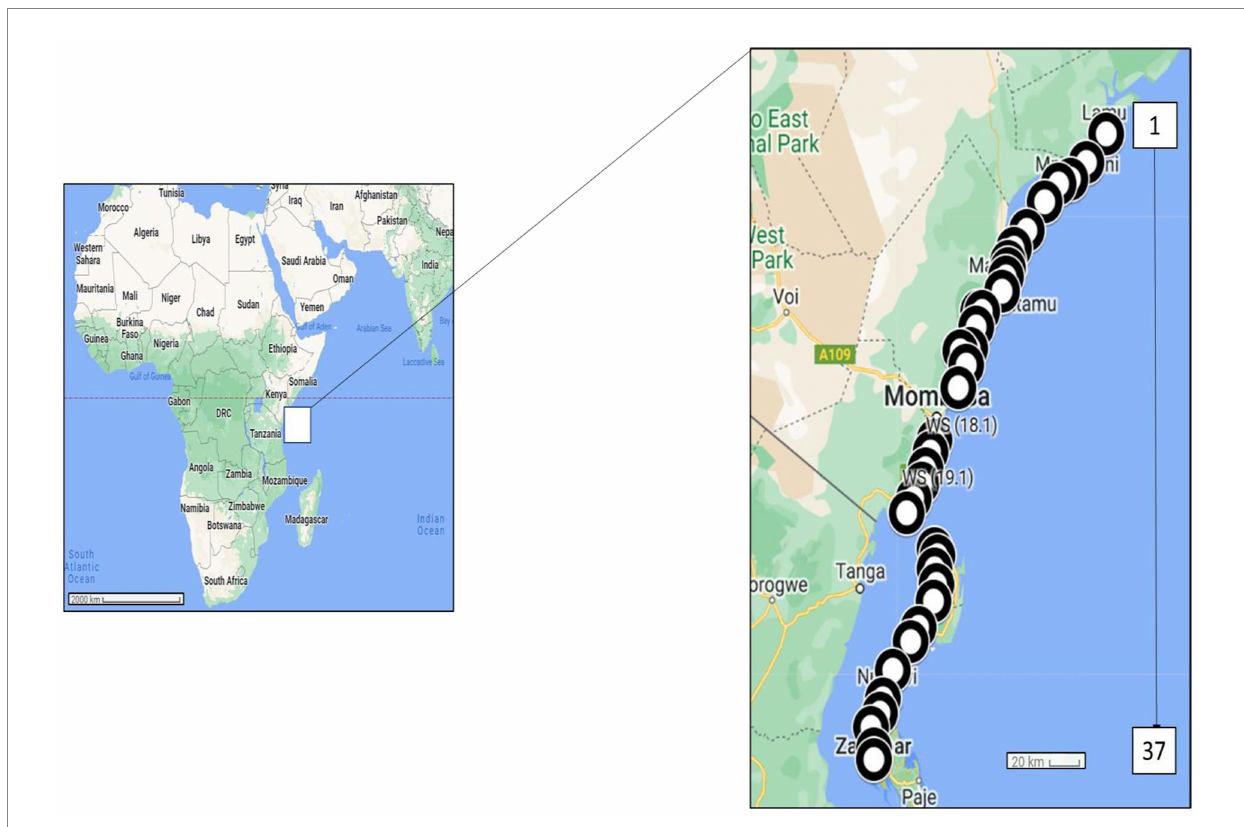
FIGURE 1 Map showing snapshot of 37 sampling locations from Lamu (Kenya) to Zanzibar (Tanzania) with arrow showing direction of